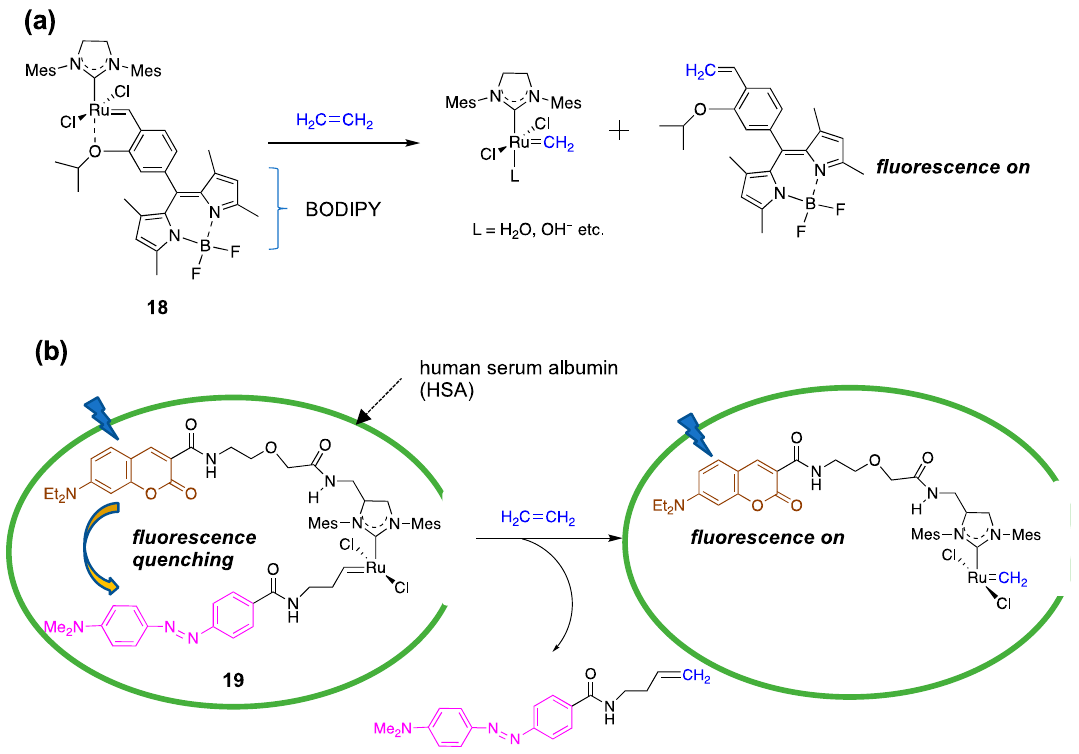
Figure 10. Hoveyda–Grubbs-type complexes developed for ethylene detection; ( a ) Ethylene detection using boron dipyrromethene (BODIPY)-modified ruthenium complex [44]; ( b ) Ethylene detection using BODIPY-modified ruthenium complex using the human serum albumin (HSA) with complex 19 [45].